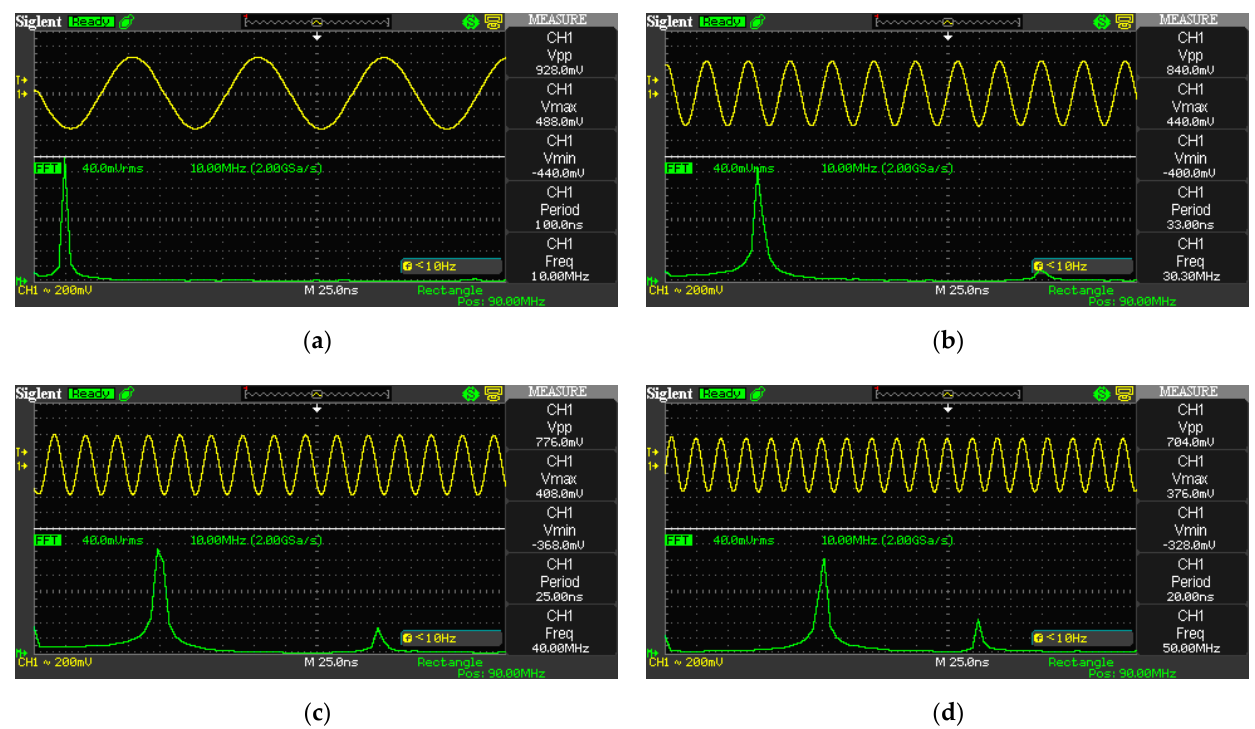
Figure 9. Experimental waveforms of signals generated by the first DDS channel of the proposed FPGA configuration structure: ( a ) 10 MHz; ( b ) 30 MHz; ( c ) 40 MHz; ( d ) 50 MHz.